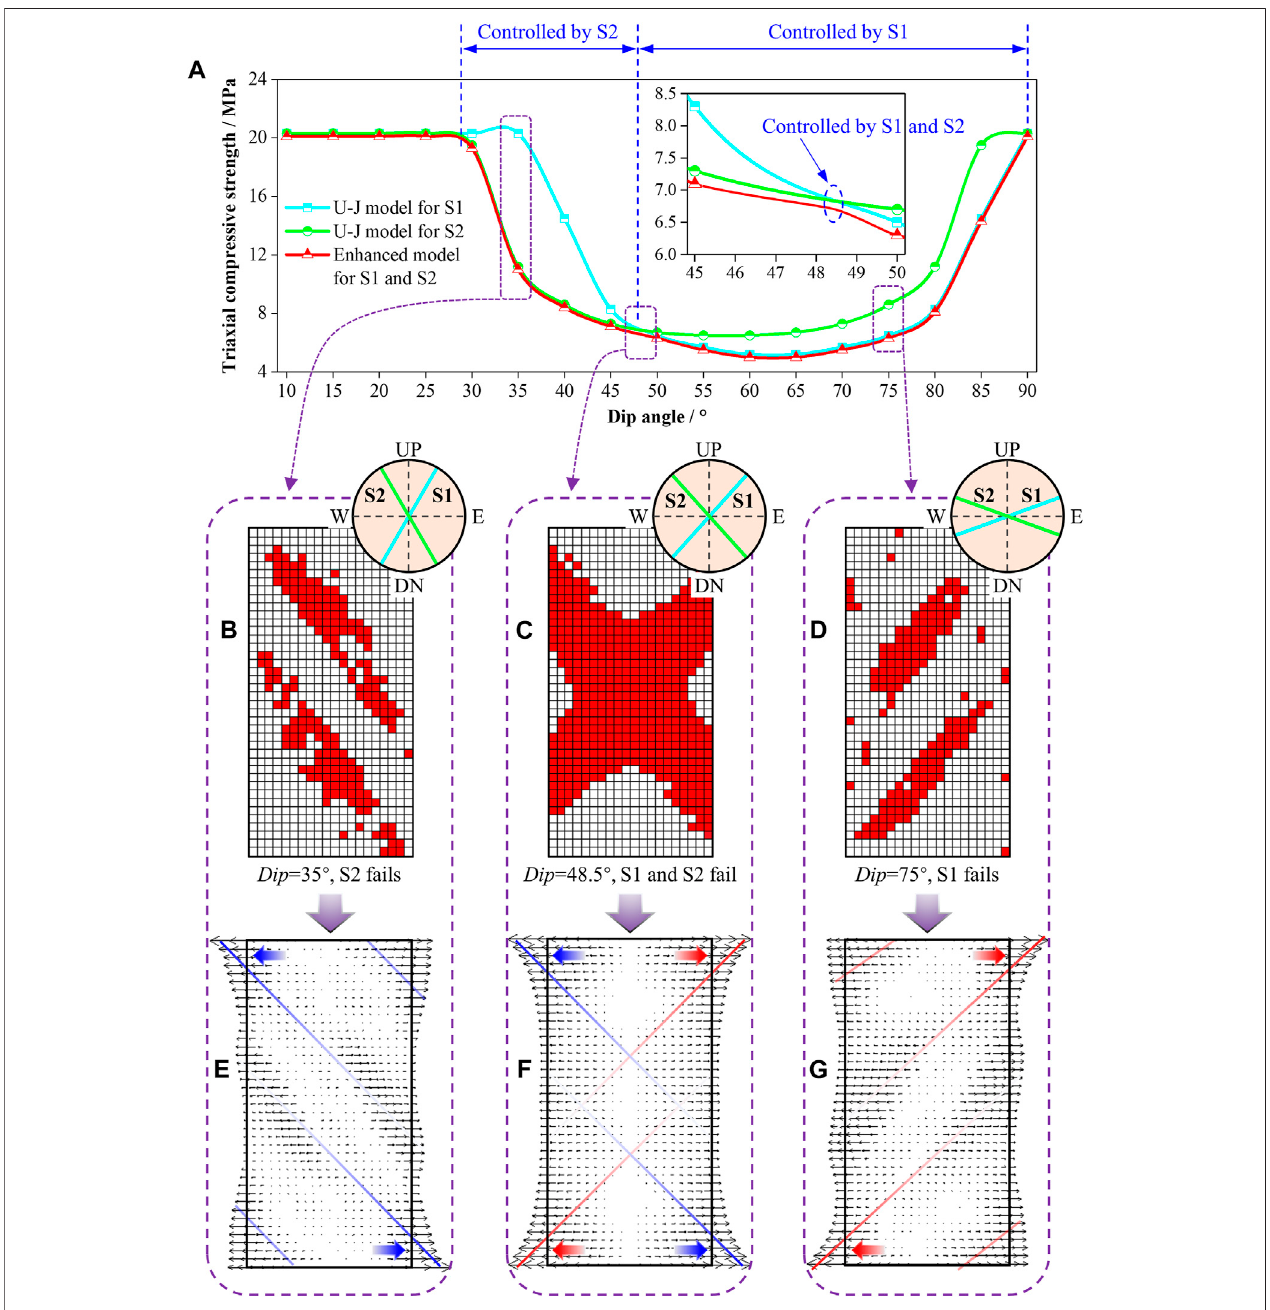
FIGURE6| Resultsoftheveri fi cationsimulation: (A) relationsbetweenthetriaxialcompressivestrengthandthedipanglesofjoints; (B – D) failuresofthejoints; (E,F) horizontal components of the total deformations.